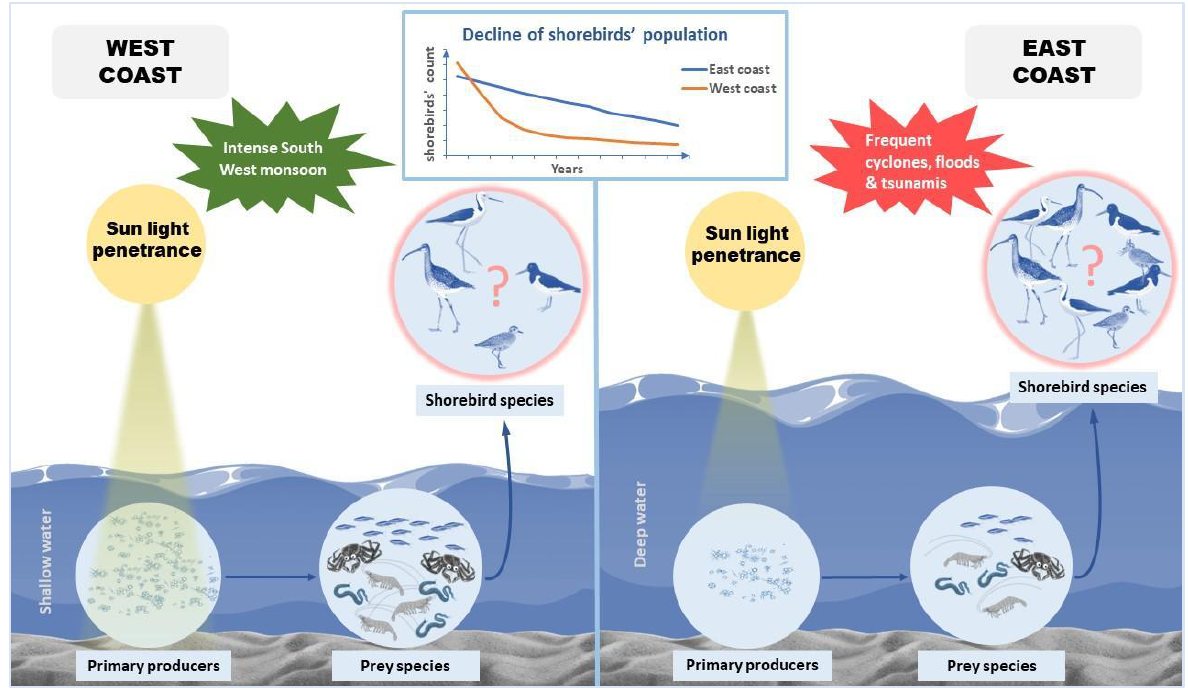
Figure 6. Ecosystem components, environmental variables and population trends in shorebirds species in the west and east coast of India.